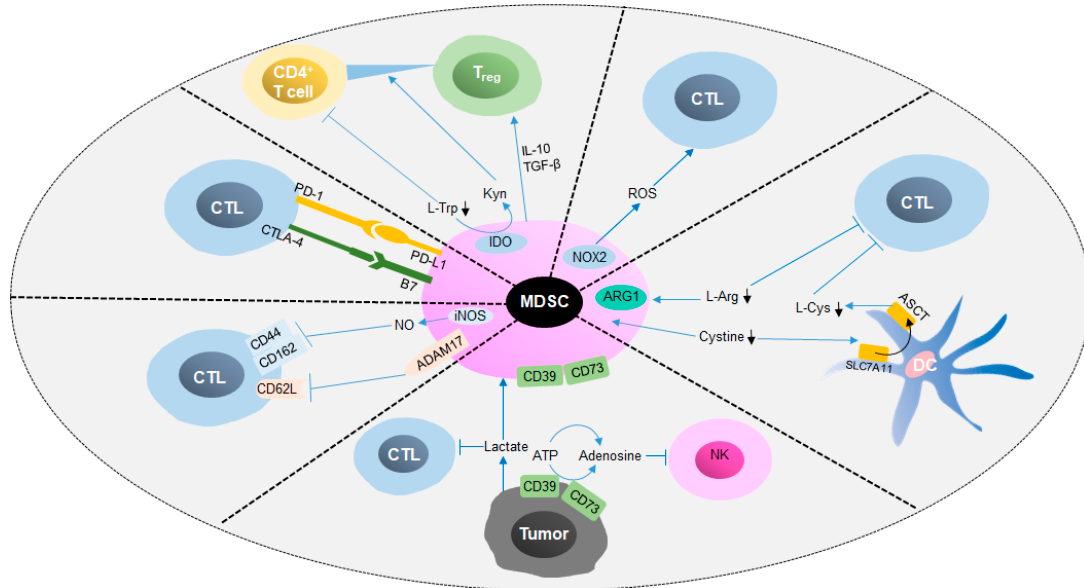
Table 3. PMN-MDSCs in